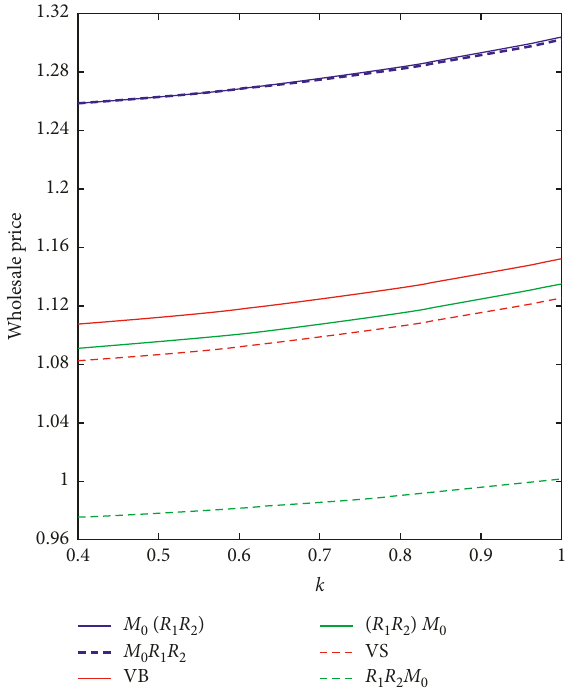
Figure 2: Effect of k on the wholesale price in decentralized